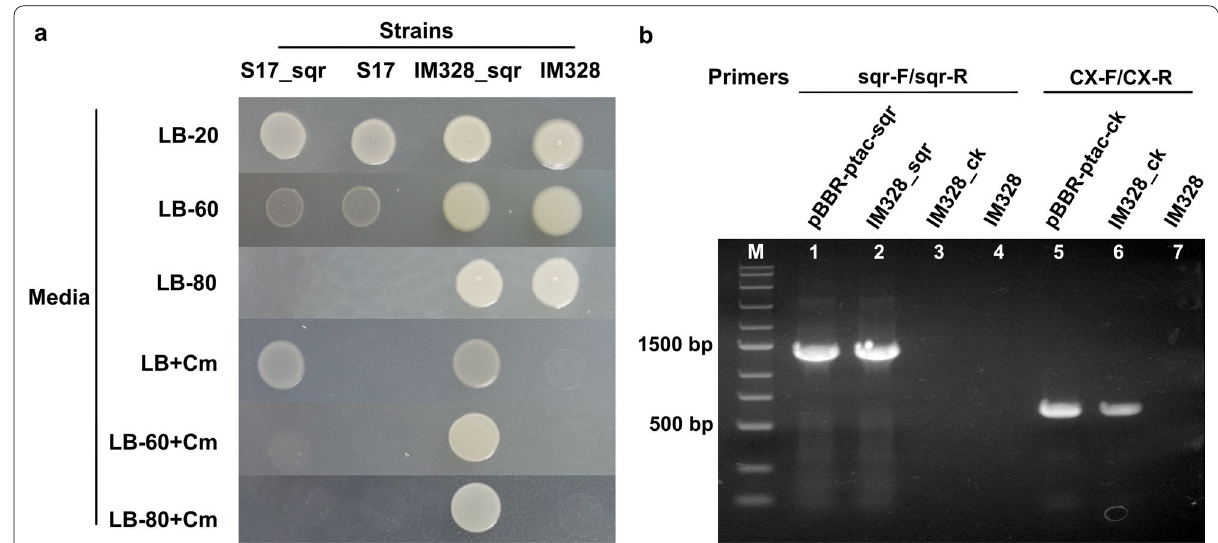
Fig. 4 Establishment of IM328 genetic transformation system. a The growth of the strains used for transformation on different solid media for screening. Cm: 25 mg/L chloramphenicol was added. b Identification of IM328_ck and IM328_sqr strain by colony PCR using primers sqr-F/sqr-R and CX-F/CX-R, respectively